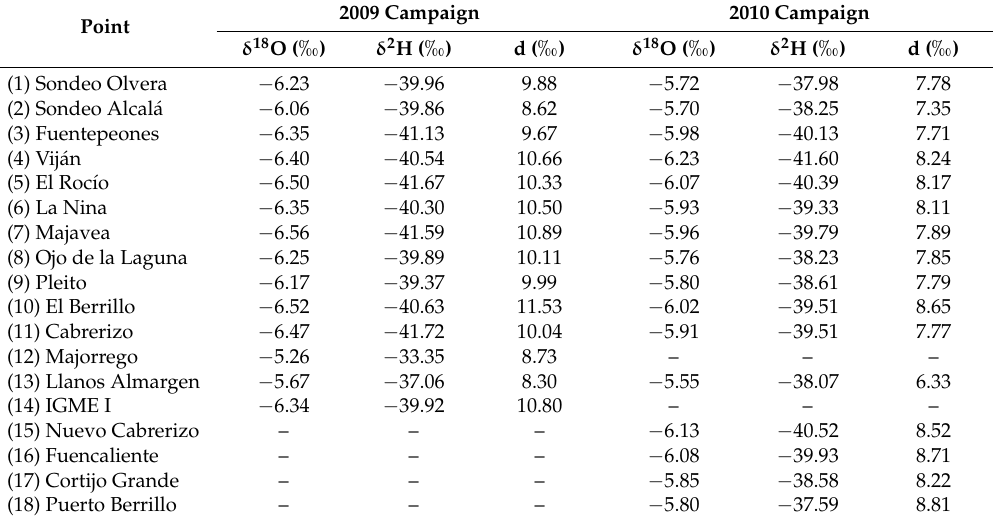
Table 3. Results of the analysis of stable isotopes in groundwater samples from the 2009 and 2010 field campaigns.